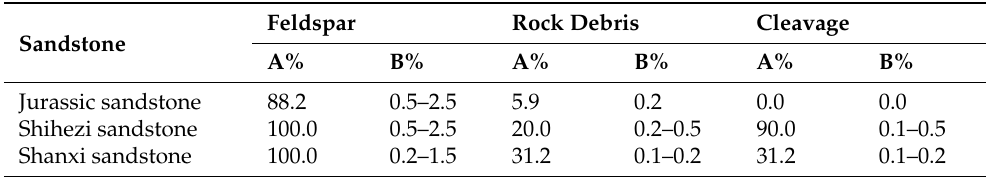
Table 2. Types, appearance probabilities and contents of intragranular pores in three layers of sandstone *.